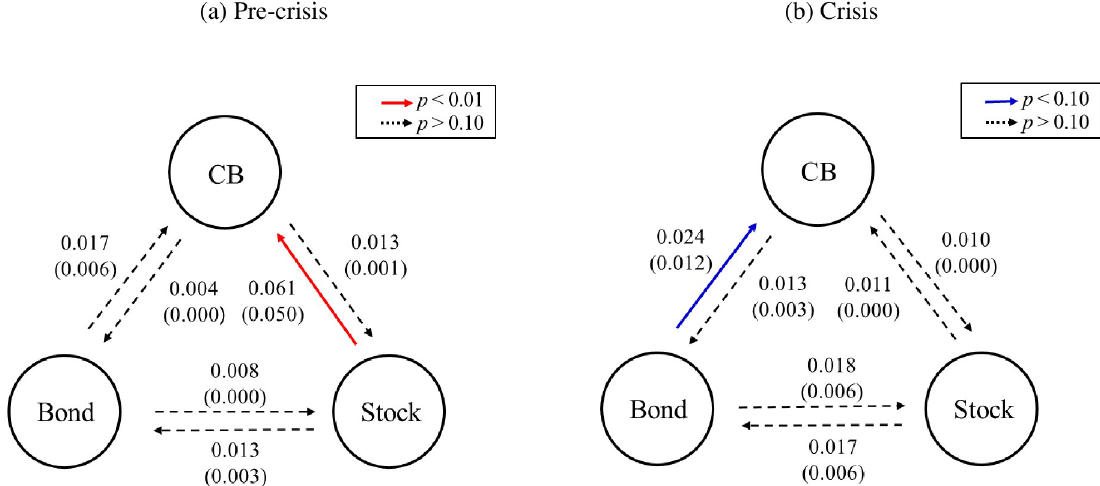
Fig 2. Information flow between CBs and other investment assets before and during the global financial crisis. The arrow indicates the direction of the causal link, the color represents the significance level (red and blue lines represent statistically significant information flows with p -value lower than 0.01 and 0.10, respectively, and the dashed line indicates insignificant TE with a p -value higher than 0.10), and p means p-value. The number denotes the estimated value of TE, and the value in parentheses stands for ETE. The significance level was evaluated by bootstrapping the underlying Markov process [26, 57]. We further apply the quantile-based TE for robustness check. In particular, cutoff points of 0.05 and 0.95 are used for the estimation (see S1 Appendix).